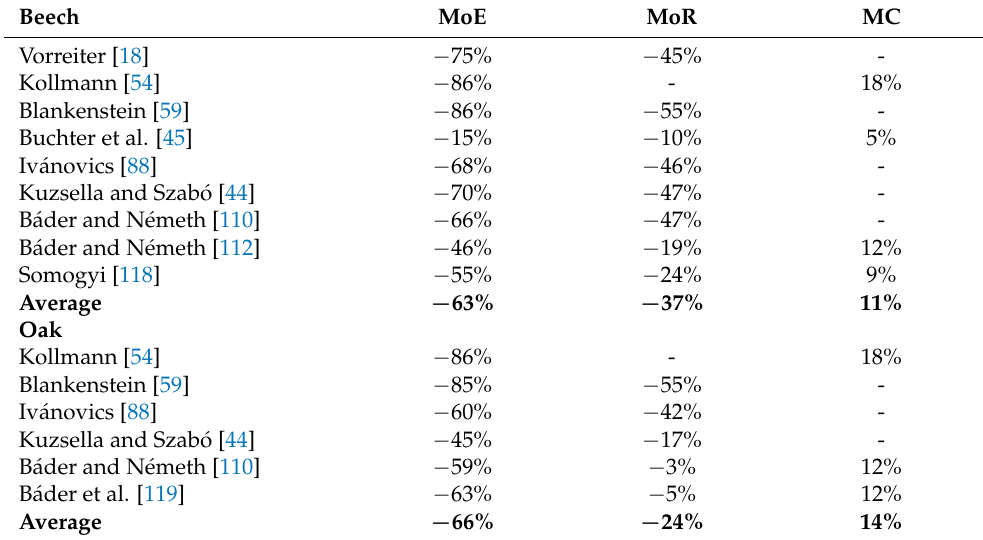
Table 1. Changes in the modulus of elasticity (MoE) and the modulus of rupture (MoR) of beech and oak due to pleating. Moisture content (MC) during the test is important; thus, it is listed in the table where